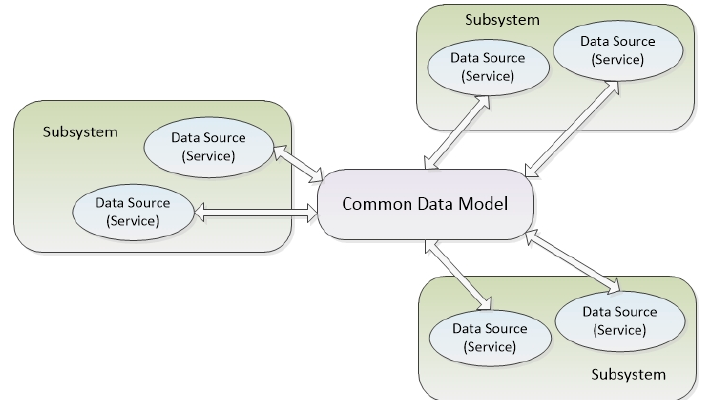
Figure 1. Common data model.